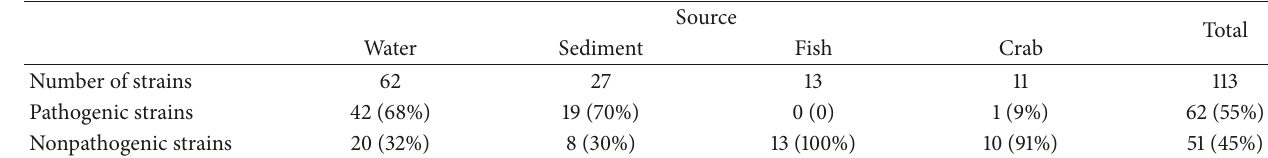
Table 2: Distribution of E. coli strains.